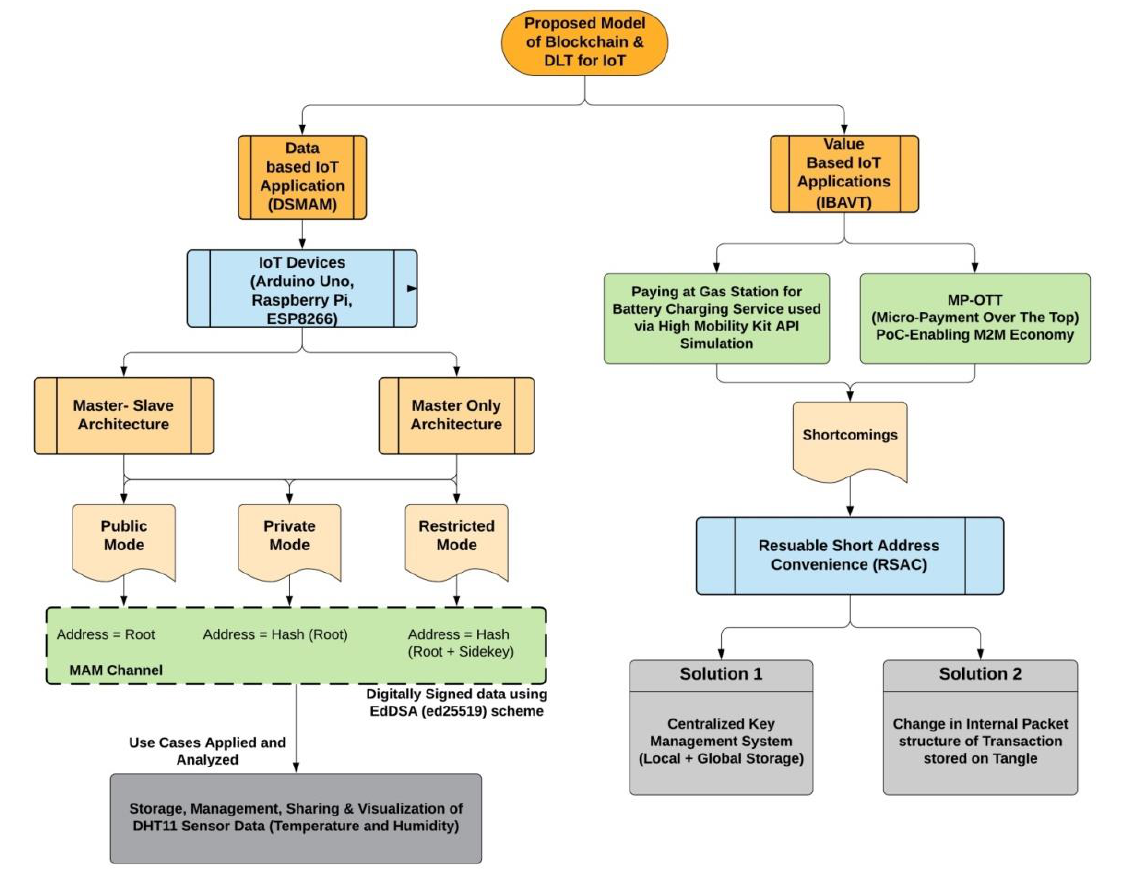
Figure 7. Proposed Architecture of DLT for IoT.